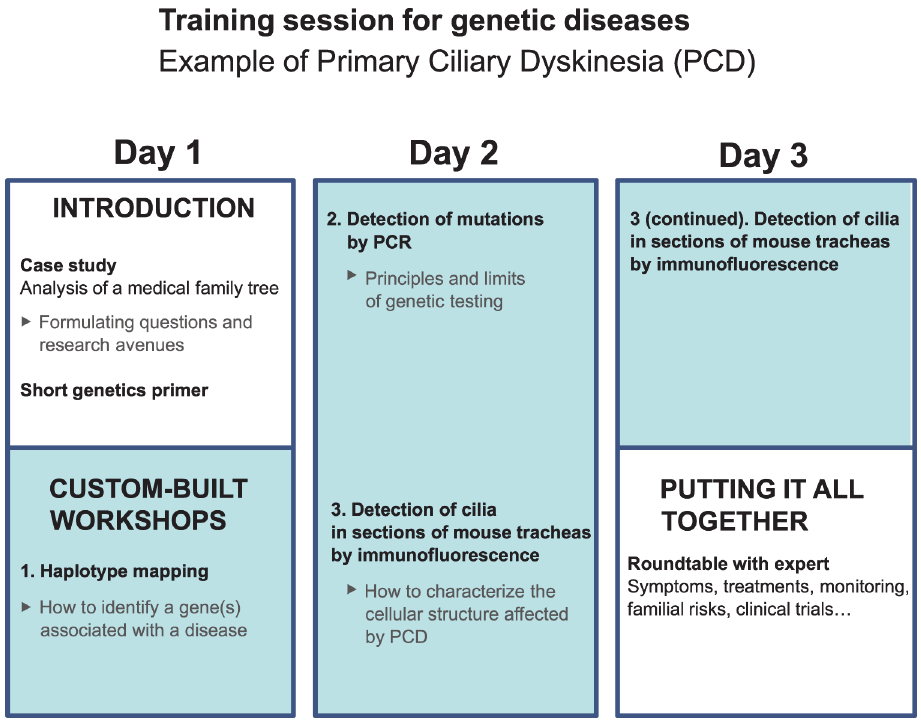
Fig 1. Layout of a typical training session for patient groups with a genetic disease. See also Fig. 2 for how we tailor each training session to a particular